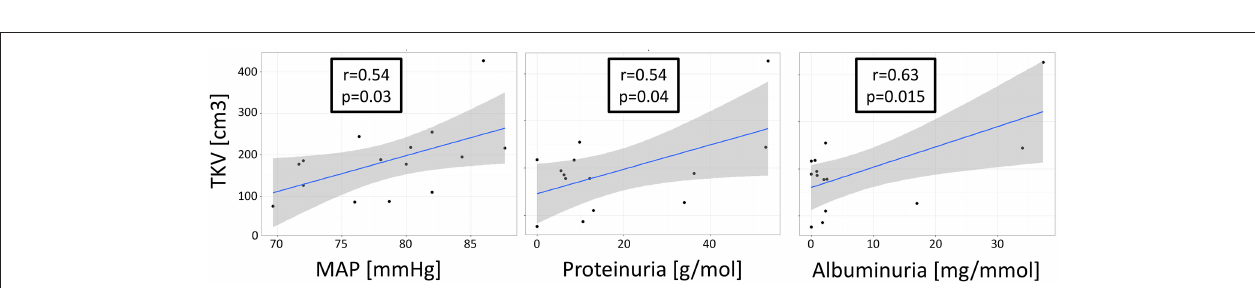
FIGURE 3 | Association between TKV and parameters of renal impairment. Correlation analysis revealed a significant association between Total Kidney Volume (TKV), mean arterial pressure (MAP), proteinuria [g/mol], and albuminuria